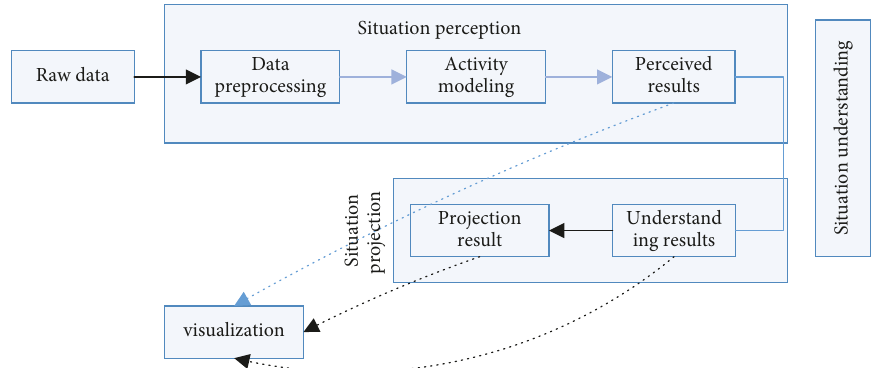
Figure 1: Security situation awareness model.